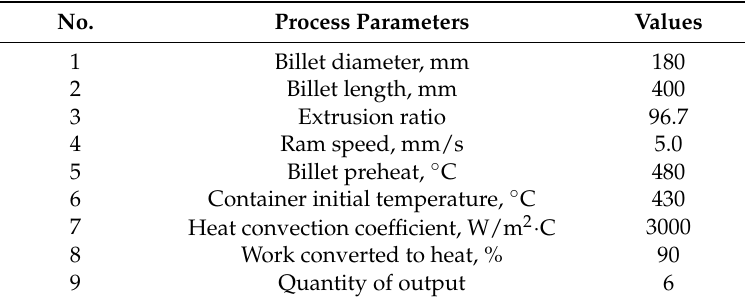
Table 3. The process parameters of the multi-output porthole extrusion.